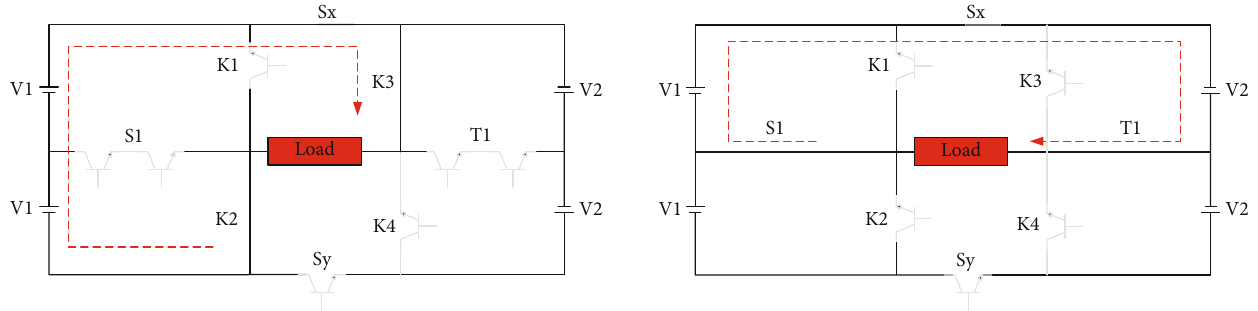
Figure 13: Current fl ow for the 11 th switching pattern. Figure 9: Current fl ow for the 7 th switching pattern.